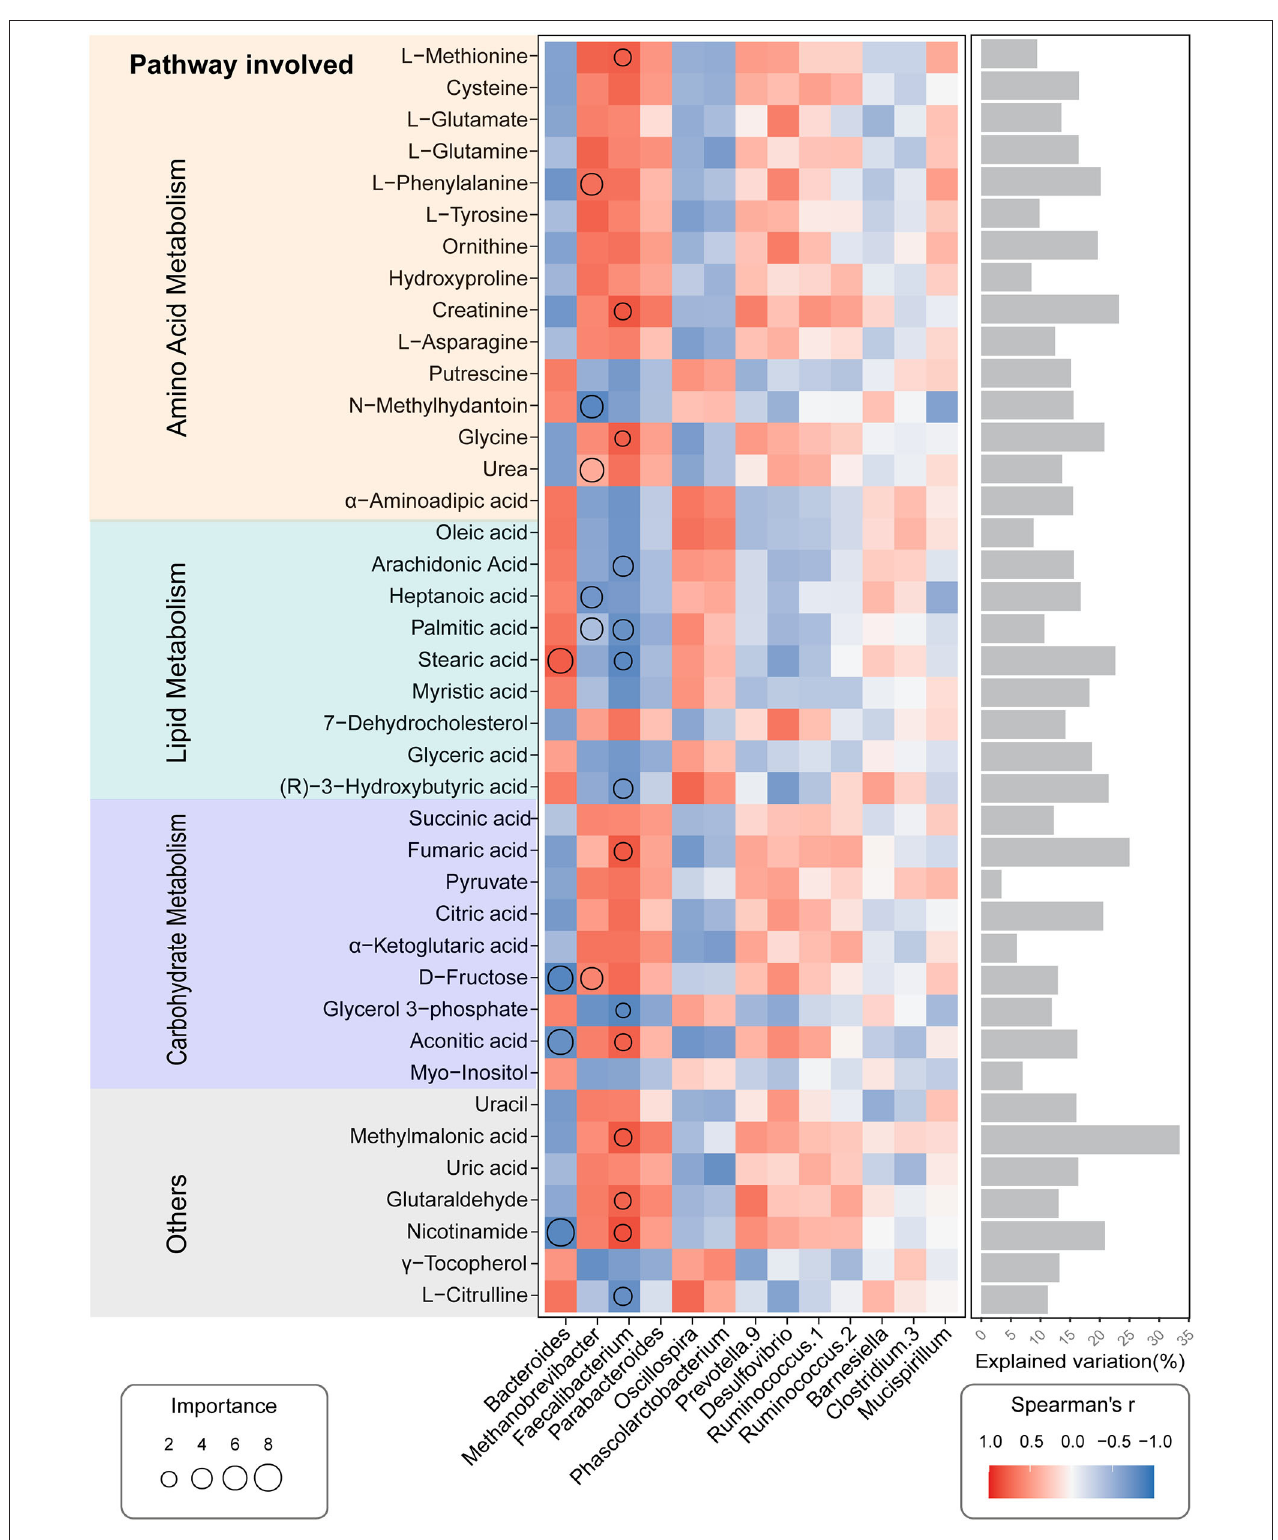
FIGURE 8 | Potential biological contributions of the cecal microbial genera to a serum metabolic profile of the CHE hens based on correlation and the random forest model. Circle size represents the variable importance. Colors and sizes of squares represent R-value of Spearman’s correlation. Bars in the right show the proportion of explained variability calculated via multiple regression modeling and variance decomposition analysis.